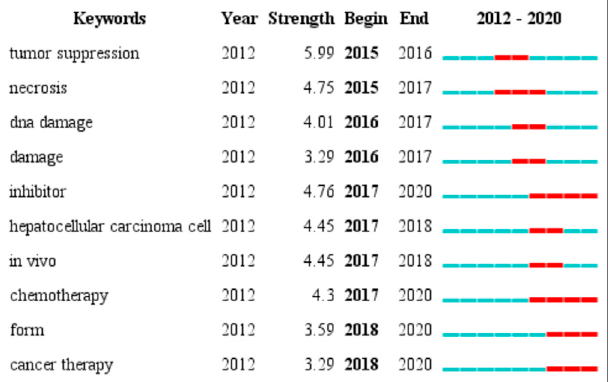
FIGURE 7 | Top 10 burst keywords in articles related to ferroptosis in cancer